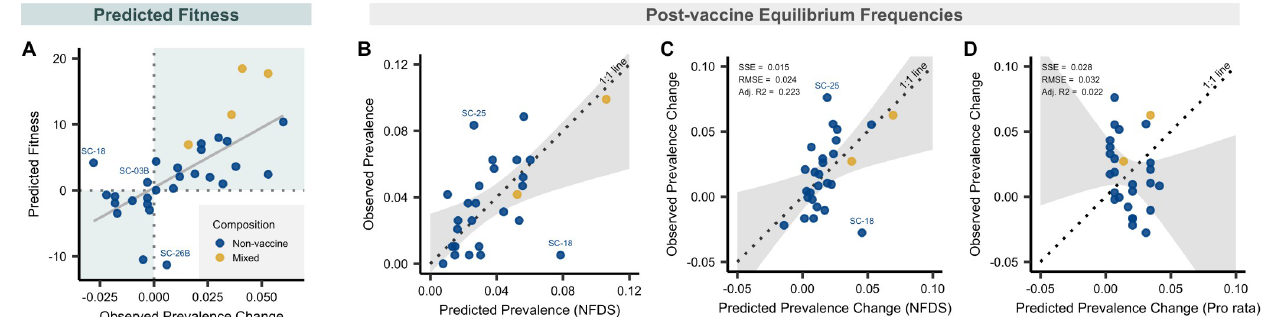
Fig 3. Predicted fitness and predicted prevalence. A , Relationship between predicted fitness and observed prevalence change from pre- to post-vaccine among 31 strains, in each case summing to 100%. Prevalence change was calculated as post-vaccine frequencies minus pre-vaccine frequencies. Predicted fitness was calculated using data solely from the pre-vaccine sample ( n = 27), with the exceptions of strains for which there were no NVT isolates present in the sample before the introduction of PCV7 ( n = 4). For those strains, data were imputed from the time point during which they were first observed. Four strains were excluded either because they were polyphyletic (SC-27) or had no NVT isolates present pre- or post-vaccine, and therefore could not be imputed (SC-04C, SC-12, and SC-17). The points are colored by serotype composition of strains: nonvaccine types in blue and mixed VT and NVT types in yellow. The shaded quadrants indicate regions of accurate prediction of the prevalence change direction (increased post-vaccine versus decreased) given the predicted fitness value. Three outlier strains are annotated for which the predicted direction of their prevalence change differed from that which was observed (i.e., they were predicted to increase based on their fitness when their prevalence from pre- to post-vaccine decreased, or vice versa). B , Scatterplot of observed versus predicted prevalence of 27 strains at post-vaccine equilibrium based on quadratic programming. These 27 strains contained at least 1 NVT strain pre-vaccine. Points are colored based on serotype composition as described in panel A . Perfect predictions would lie on the dotted line of equality (1:1 line). The shaded gray region shows the CI from the linear regression model used to test for deviation of the observed versus predicted values compared with the 1:1 line. Two outliers are annotated for which the difference between their predicted and observed prevalence was > 1.5 times the interquartile range of the distribution of predicted and observed prevalence differences. As a note, the predictions remained significant if SC-09 (the extreme strain at 10% prevalence in B) was removed (slope, 95% CI 0.021–1.05; intercept, 95% CI − 0.003 to 0.03; p = 0.19, chi-squared = 3.5). C-D , Comparison of the predicted prevalence change from quadratic programming analysis using accessory genes and naive pro rata model as shown in Fig 1B but applied to just these 27 strains. The dotted line of equality (1:1 line) and CI (gray) are shown as in panel B. Goodness-of-fit statistics including SSE, RMSE, and degrees of freedom Adj. R 2 are given for each model. The lower SSE and RMSE indicate a better model fit. See S1 Data and S1 Code for details. Adj. R 2 , adjusted R -squared; NFDS, negative frequency-dependent selection; NVT, nonvaccine serotype; PCV7, 7-valent pneumococcal conjugate vaccine; RMSE, root mean squared error; SC, sequence cluster; SSE, sum of squared errors; VT, vaccine serotype.